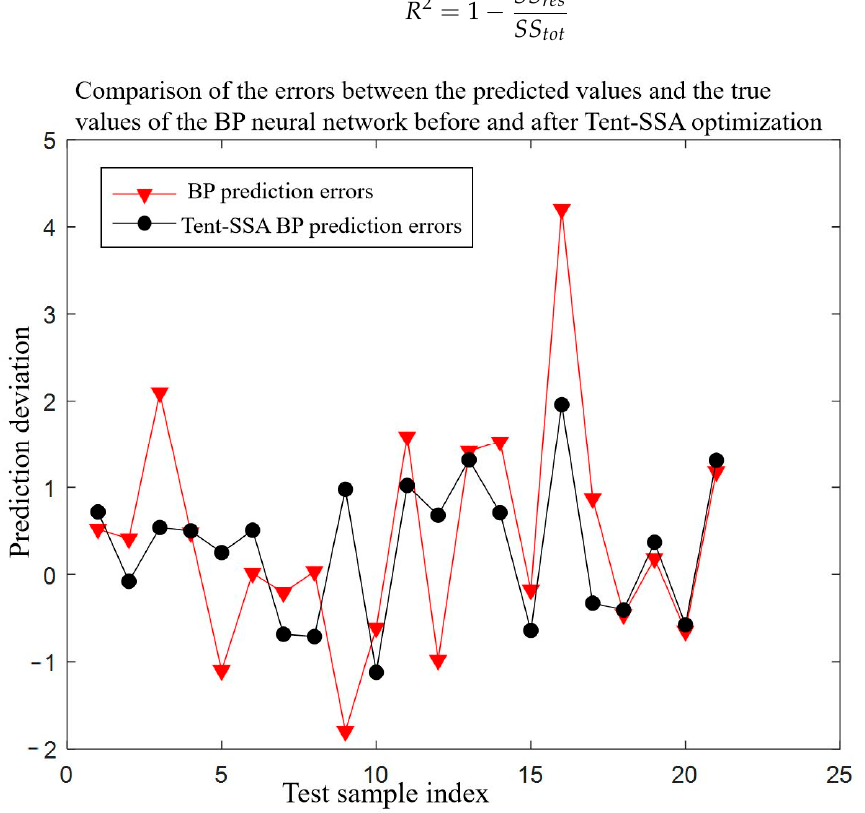
Figure 15. The prediction errors before and after optimization. Figure 16 is a schematic diagram of the comparison between the predicted life values and the measured values of the 20 test sets. As shown in Figure 16, the predicted life values were close to the measured ones, and there were small errors between them. Thus, this prediction model had a be tt er prediction e ff ect.